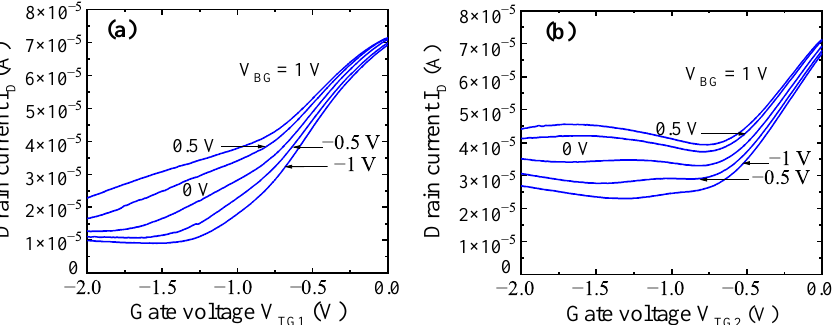
Figure 5. Drain current as a function of the gate voltage (transfer current–voltage characteristics) of a grating gate transistor when gate voltage V TG 1 was applied to the first top gate with L G 1 = 1.85 µm while keeping V TG 2 = 0 V ( a ), and while varying V TG 2 with L G 2 = 3.7 µm and keeping V TG 1 = 0 V ( b ). Measurements were taken at different back gate voltages V BG .